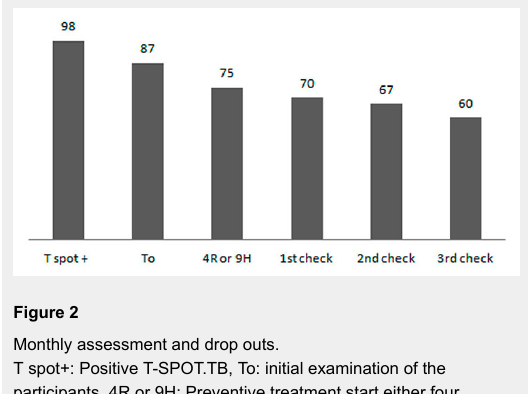
Monthly assessment and drop outs. T spot+: Positive T-SPOT.TB, To: initial examination of the participants, 4R or 9H: Preventive treatment start either four months of rifampicin or nine months of